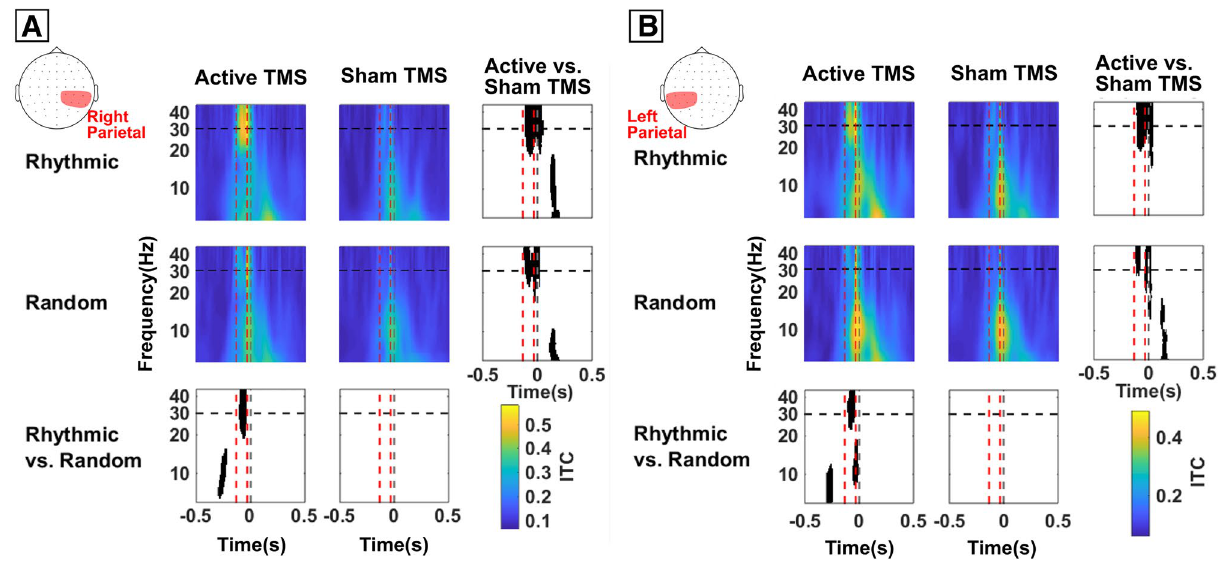
Figure 5. Temporal dynamics and frequency-specificity of distant phase-locking of high beta oscillations on parietal regions across stimulation patterns delivered to the right FEF. Time frequency plot of inter-trial coherence (ITC) over right parietal ( A ) and left parietal ( B ) scalp EEG electrodes. Time frequency panels are arranged following a 2 × 2 crossed factorial design, in which we compared sham vs. active TMS condition (rows) and random vs. rhythmic TMS patterns (columns). Time is centered on the onset of the target (vertical dotted grey line, t = 0). Vertical dotted red lines indicate the time window between the 1st (− 133 ms) and the 4th and last (− 33 ms) TMS pulses of the delivered stimulation pattern. The horizontal dotted black line indicates the frequency of rhythmic TMS stimulation (30 Hz). Bottom and right panels present the outcomes of the statistical permutation tests, with black pixels indicating clusters that reached statistical significance between TMS conditions (p < 0.05), either active/sham rhythmic vs active/sham random (bottom row) or active rhythmic/ random vs. sham rhythmic/random (right column). Note that rhythmic stimulation of the right FEF increased inter-trial coherence in the high-beta range distantly over right and left parietal EEG contacts, whereas random stimulation patterns increased phase-locking transiently in the alpha frequencies in parietal EEG leads contralateral to the site of right FEF